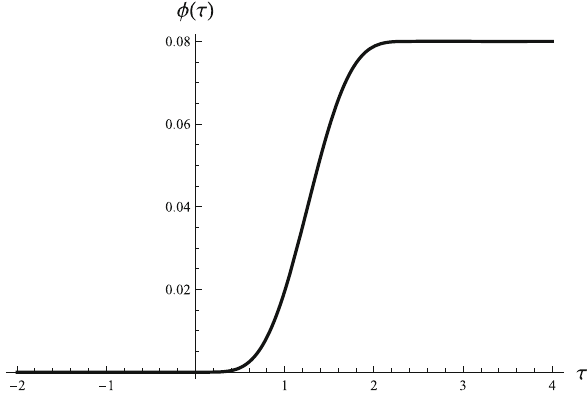
Fig. 1 An example of φ(τ) , where φ 0 = 0, φ 1 = 0 . 08, and (cid:19) = 0 .